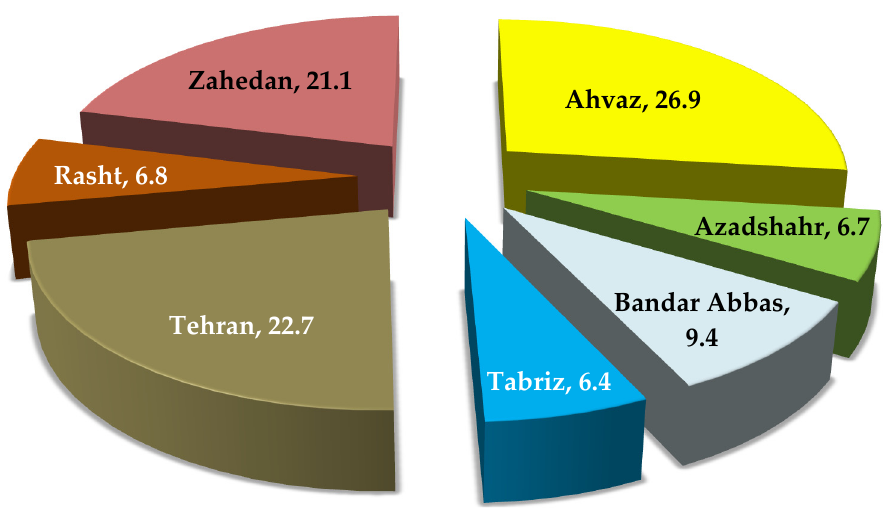
Figure 8. Final scores of alternatives.